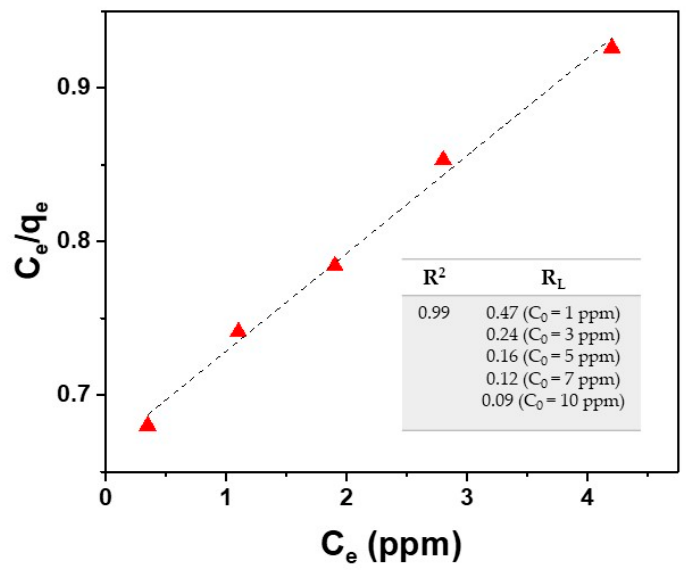
Figure 8. Fitting of experimental data (red triangle) by using the Langmuir isotherm model for Cu 2+ ions (Equations (3) and (5)).